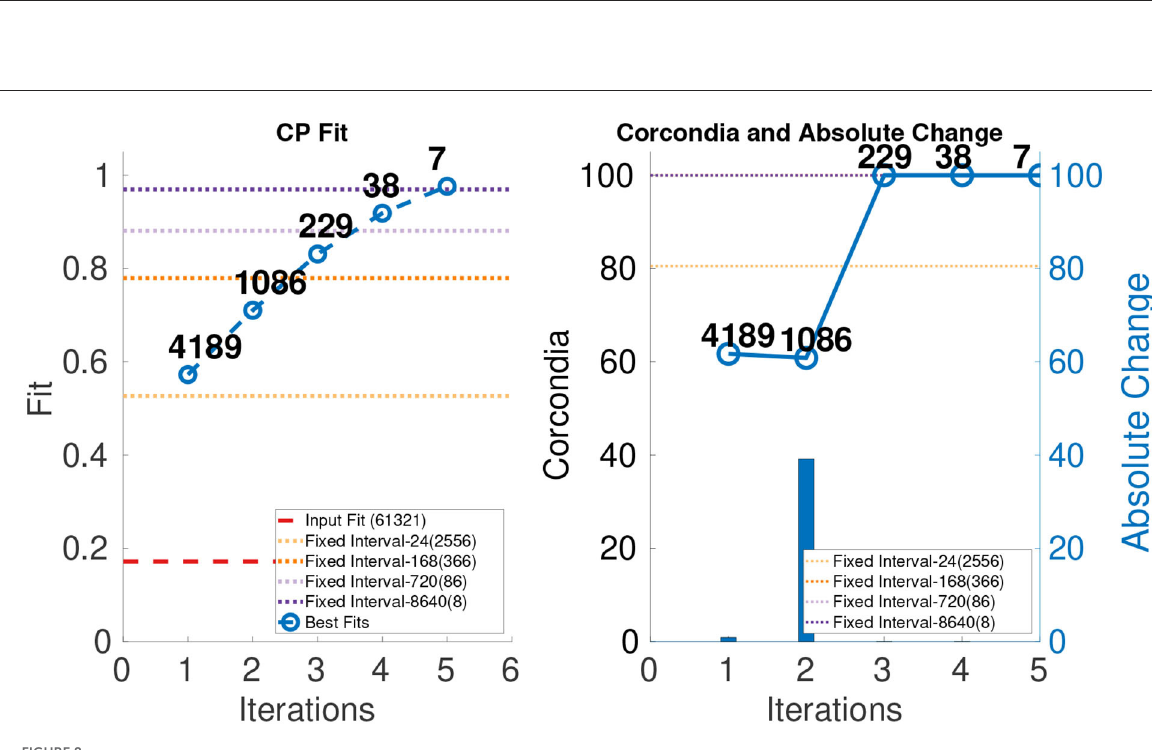
FIGURE8 CP fit and CORCONDIA of best fit tensor and its absolute change at each iteration for Chicago Crime